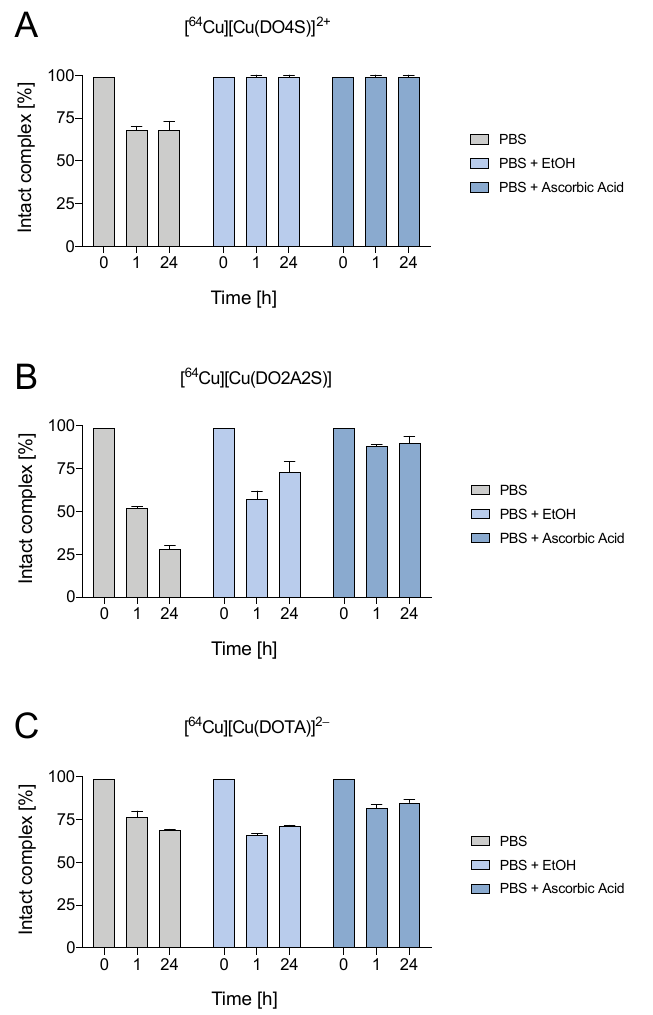
Figure 6. Stability of [ 64 Cu]Cu 2+ -complexes prepared at 25 MBq/nmol in PBS with and without the additions of radioprotectants (ethanol 10% v / v and ascorbic acid 10% v / v ). ( A ): [ 64 Cu][Cu(DO4S)] 2+ ; ( B ): [ 64 Cu][Cu(DO2A2S)]; ( C ) [ 64 Cu][Cu(DOTA)] 2 − .